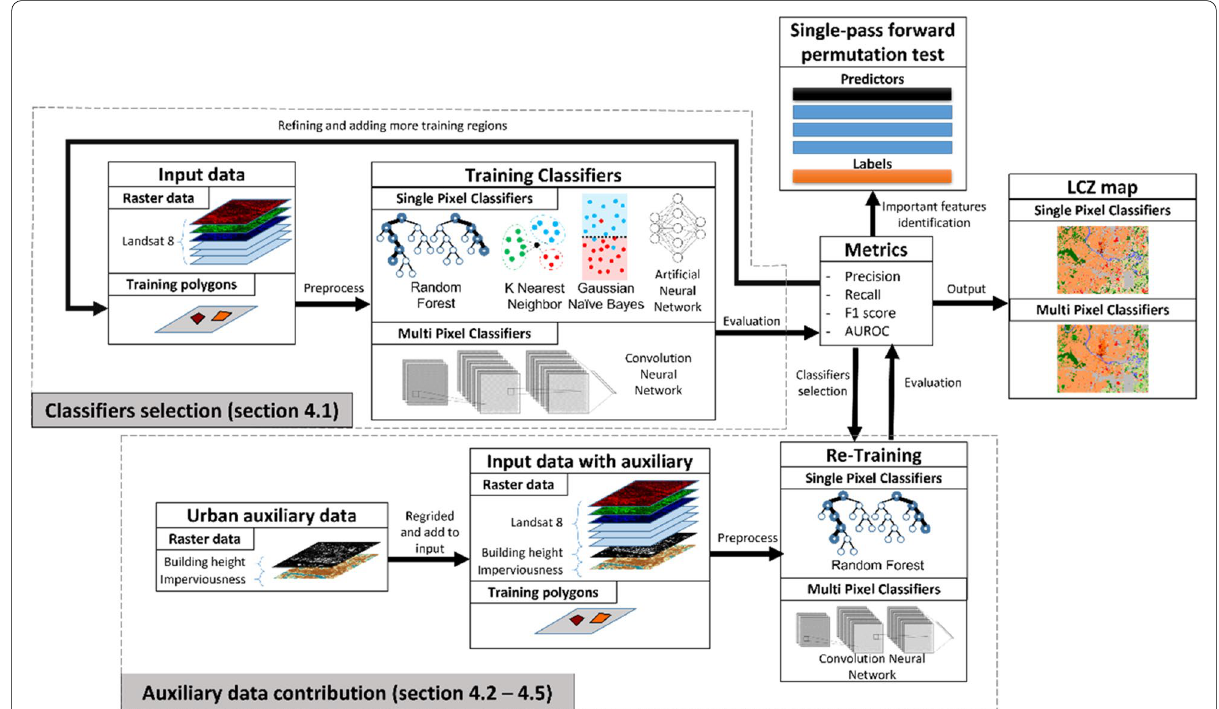
Fig. 2 A workflow summary for this